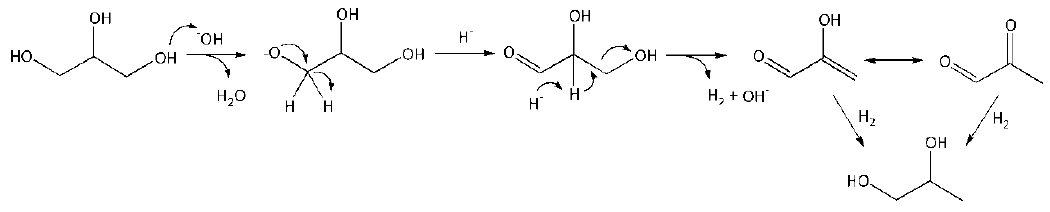
Figure 7. A schematic conversion of glycerol into PG in the volume.